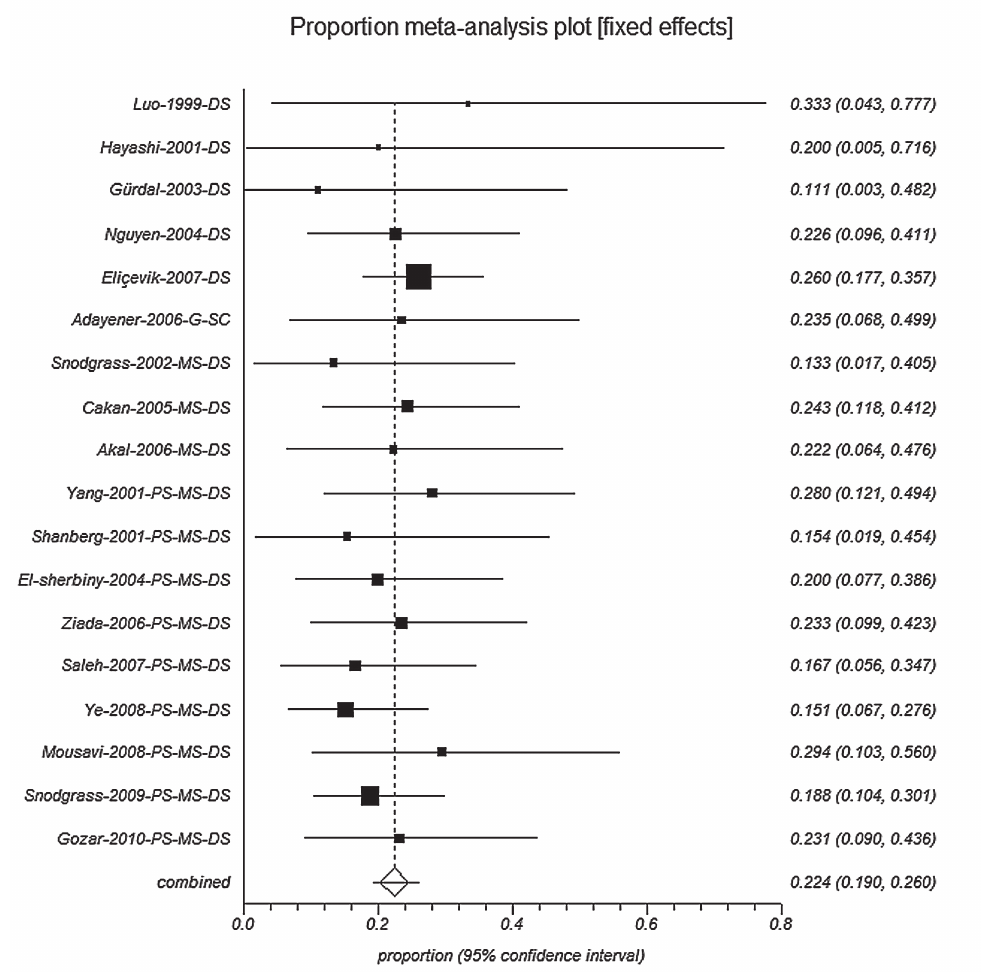
figure 2 - forest plot of fistula as a complication in 17secondary (redo) hypospadias operation studies, (Cochran Q = 10.4 (df = 16), P = 0.848, I² =